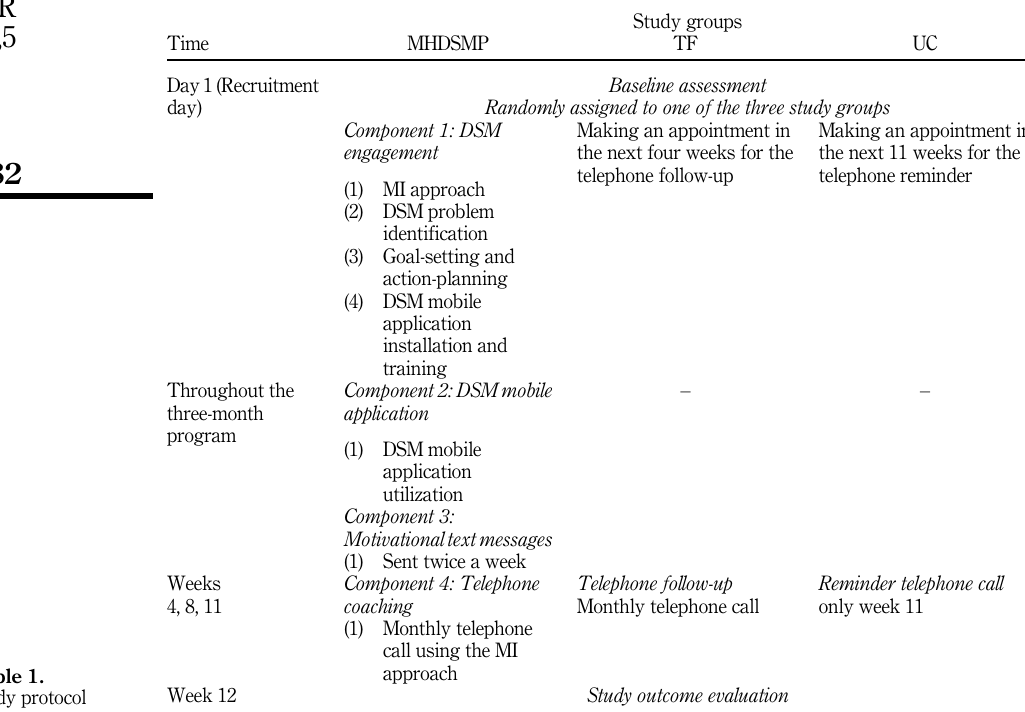
Study outcome evaluation